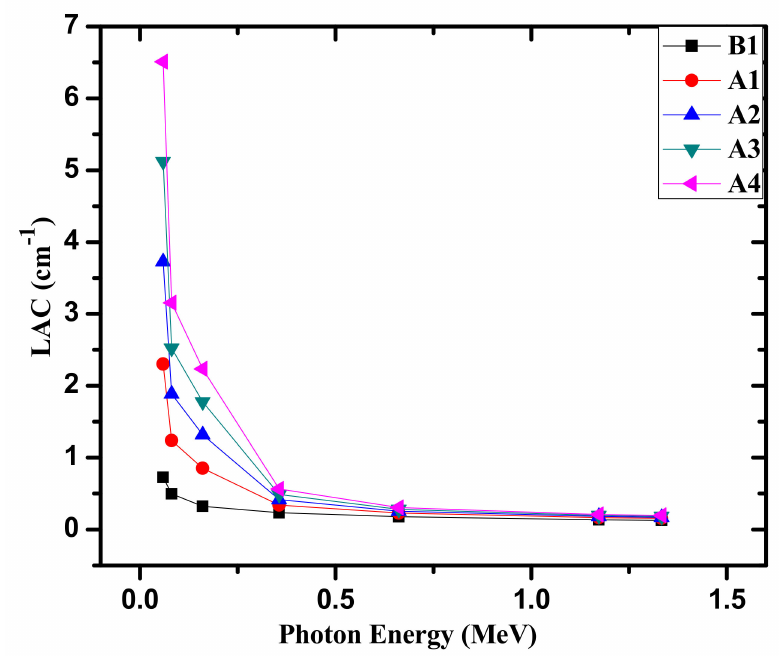
Figure 3. The linear attenuation coefficient for the fabricated glasses.